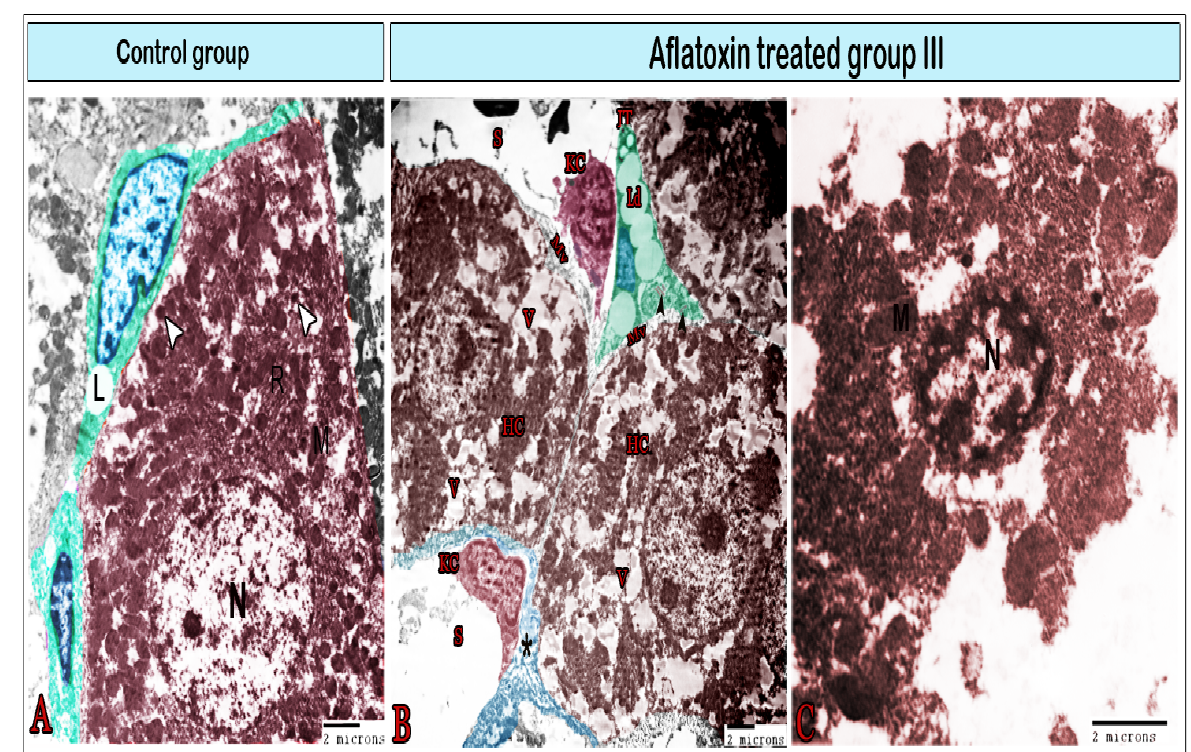
Figure 6. Digital colored transmission electron microscopy micrographs of the control group ( A ) and aflatoxin B1-treated group III ( B, C ). ( A ) Normal hepatocytes with a large round nucleus (N); cytoplasm contains the mitochondria (M), rER, and lysosomes (arrowheads); Ito cells (green color) surrounding the hepatocyte contain lipid droplets (L). ( B ) Hepatocytes (HC) demonstrated exaggerated amounts of vacuoles (V); microvilli (MV) on their surface; Ito cells (IT) with a significant increase in lipid droplets (Lp) that condense the nucleus (blue), and collagen bundles within the cell (arrowheads). Kupffer cells (KC) were observed within the sinusoids (s), which were surrounded by a thick layer of fibrous tissue (*). ( C ) Necrotic hepatocyte exhibiting vacuolation, karyolysis, plasma membrane rupture, and release of cellular contents (note the nucleus (N) and mitochondria (M)).